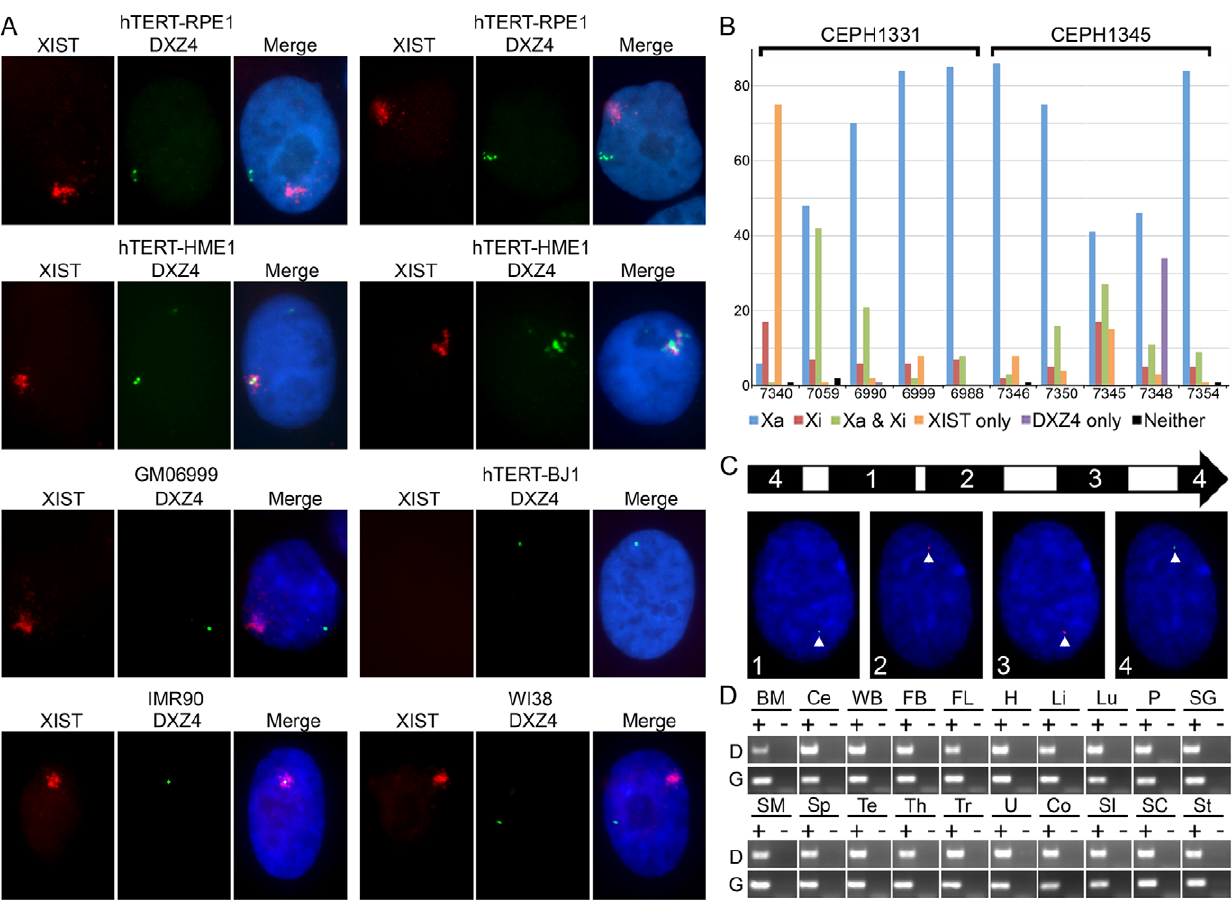
Figure 5. Expression of DXZ4. (A) Examples showing the distribution of DXZ4 RNA versus XIST RNA in various 46,XX cells and a 46,XY cell line. The cell identity is indicated above each panel of three images. XIST RNA is shown in red, DXZ4 in green and nuclei are stained with DAPI (blue) in the merged image. (B) Expression of DXZ4 from the Xa and Xi in ten independent female lymphoblast cell lines given on the x-axis. Number of nuclei are given on the y-axis as percent. One hundred nuclei were scored for each cell line. (C) Detection of distinct regions of DXZ4 RNA by RNA FISH. The right facing arrow represents a single DXZ4 monomer with the regions highlighted in black (1–4) indicating the location of the probes used. Beneath this are examples of RNA FISH signals for each probe merged with DAPI. (D) RT-PCR analysis of DXZ4 using cDNA generated from total RNA isolated from 20 different human tissues. The tissues are listed above each agarose gel image, with a ‘‘ + ’’ indicating cDNA with reverse transcriptase and ‘‘ 2 ’’ indicating the no reverse transcriptase control. The top row indicates DXZ4 (labeled ‘‘D’’) whereas the lower lane indicates GAPDH (labeled ‘‘G’’). BM – bone marrow; Ce – cerebellum; WB – whole brain; FB – fetal brain; FL – fetal liver; H – heart; Li – liver; Lu – lung; P – prostate; SG – salivary gland; SM – skeletal muscle; Sp – spleen; Te – testis; Th – thymus; Tr – trachea; U – uterus; Co- colon; SI – small intesitine; SC – spinal cord; St –